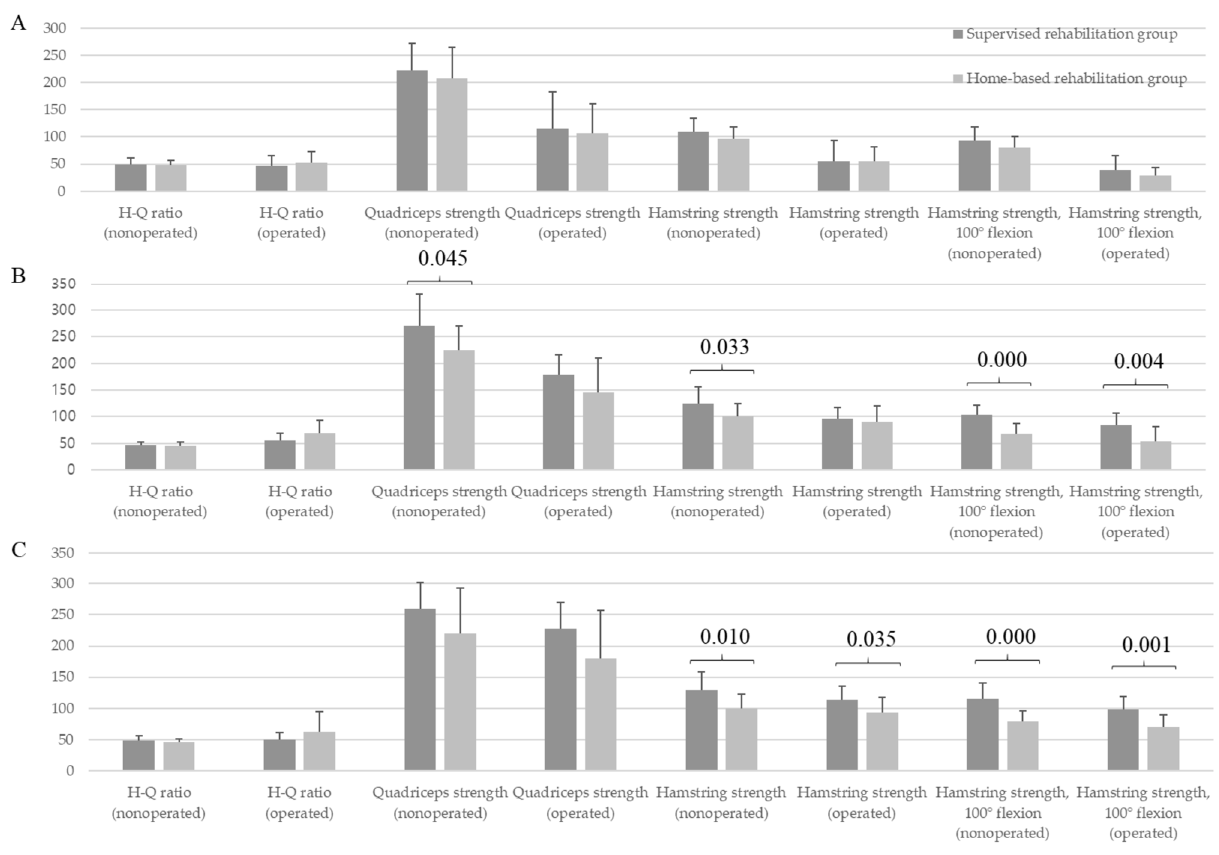
Figure 1. Comparison of muscle ratio and strength of quadriceps and hamstring between the supervised rehabilitation group and home-based rehabilitation group. ( A ) Preoperative baseline, ( B ) At postoperative 6 months, and ( C ) At postoperative 1 year.